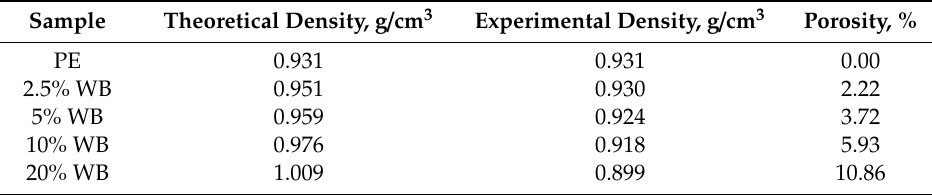
Table 2. Physical and structural properties of PE-WB